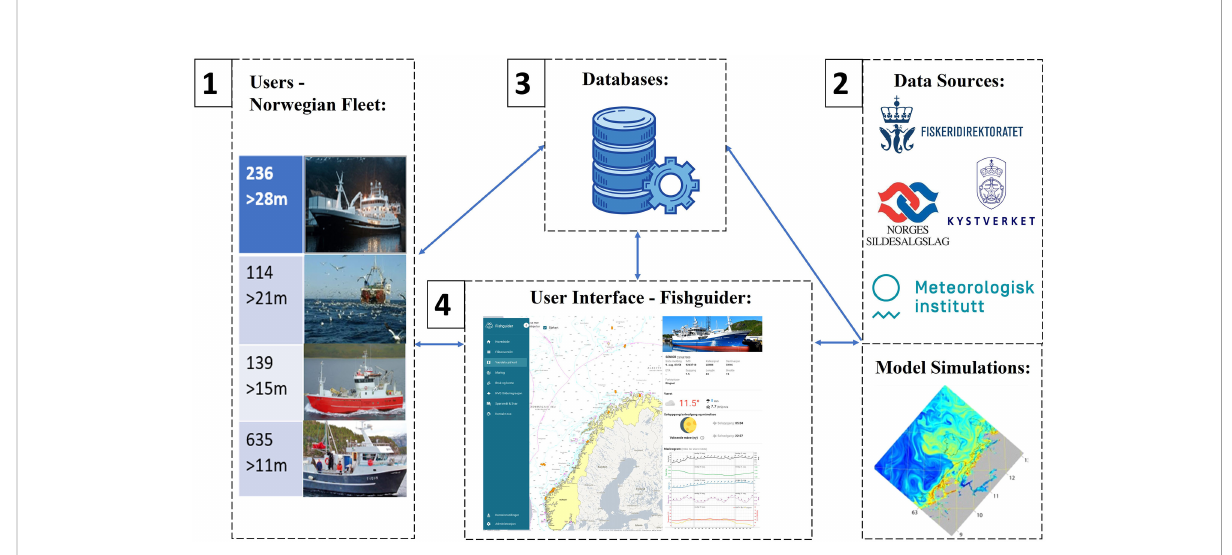
FIGURE 1 Conceptual model of the Fishguider tool: 1) The Norwegian Fleet of vessels over 11m in length who may contribute information, both from experiential knowledge and from information systems onboard vessels (such as satellite and acoustic data). 2) Fishers can access external information, such as meteorological forecasts, real-time auction prices and relevant model output. 3) The data sources are collected in databases developed in conjunction with the project. 4) The fi nal user interface is a web portal that displays relevant layers to the skipper. The design of the interface is largely driven by the requests of participating fi